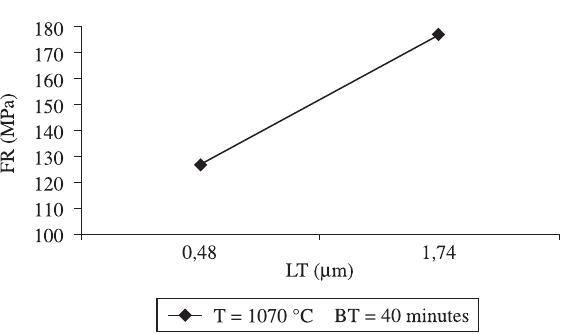
Figure 4. Flexural resistance (FR) as function of Ti layer thickness (LT) for brazing temperature (T) of 1070 °C and brazing time (BT) of 40